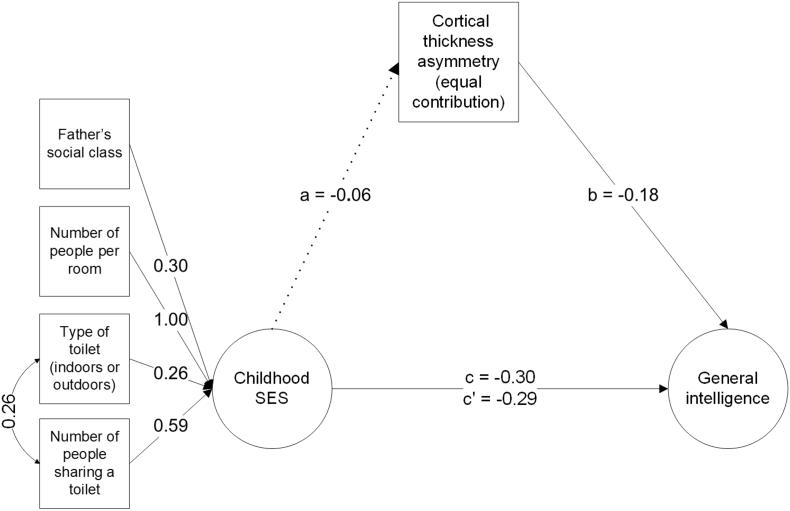
Simplified mediation model estimating the mediation of thickness asymmetry on the association between childhood SES and general intelligence. See also Fig. 3 and Supplementary Table 10.